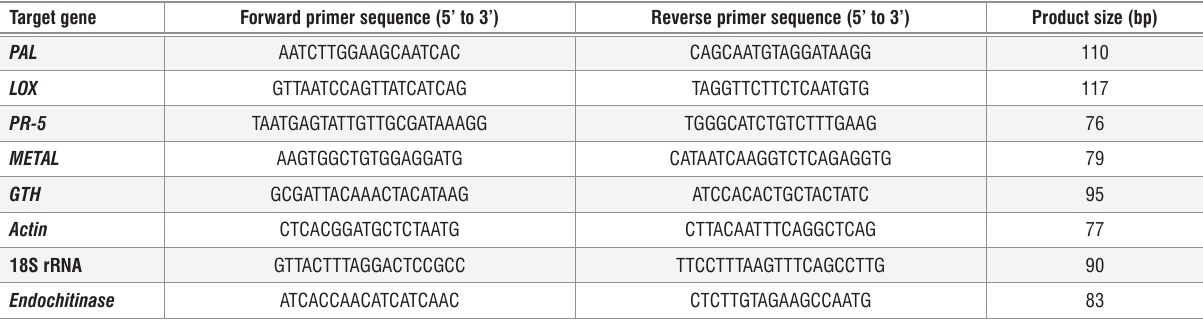
Primer sequences of defence-related genes studied in avocado roots by quantitative reverse transcription PCR following infection by Phytoph­ thora